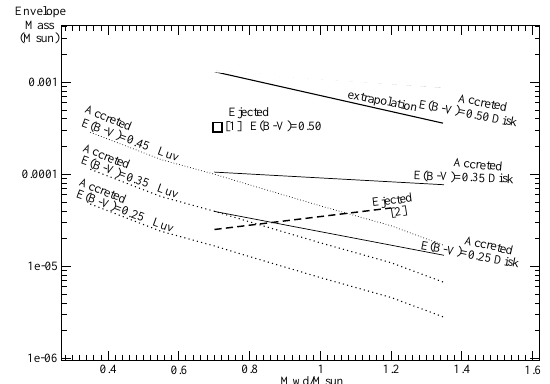
Figure 4: The mass of the accreted envelope and ejected envelope are shown as a function of the WD mass for different values of the reddening for T Pyx. Our disk model results are drawn with a solid line (“Disk”). The lower limit of the accreted envelope in- ferred from the UV flux is shown (dotted line, “Luv”). In comparison we show the ejected envelope [1] as esti- mated by Nelson et al. (2012) (square symbol), as well as [2] computed in Patterson et al. (2013) (dashed line). The accreted envelope is larger than the ejected enve- lope, except for a value of E(B-V)=0.25 combined with a WD mass ∼ 0 . 9 M (cid:12) and larger. However, the best re- sults were obtained for a larger value of the reddening E ( B − V ) > 0 .